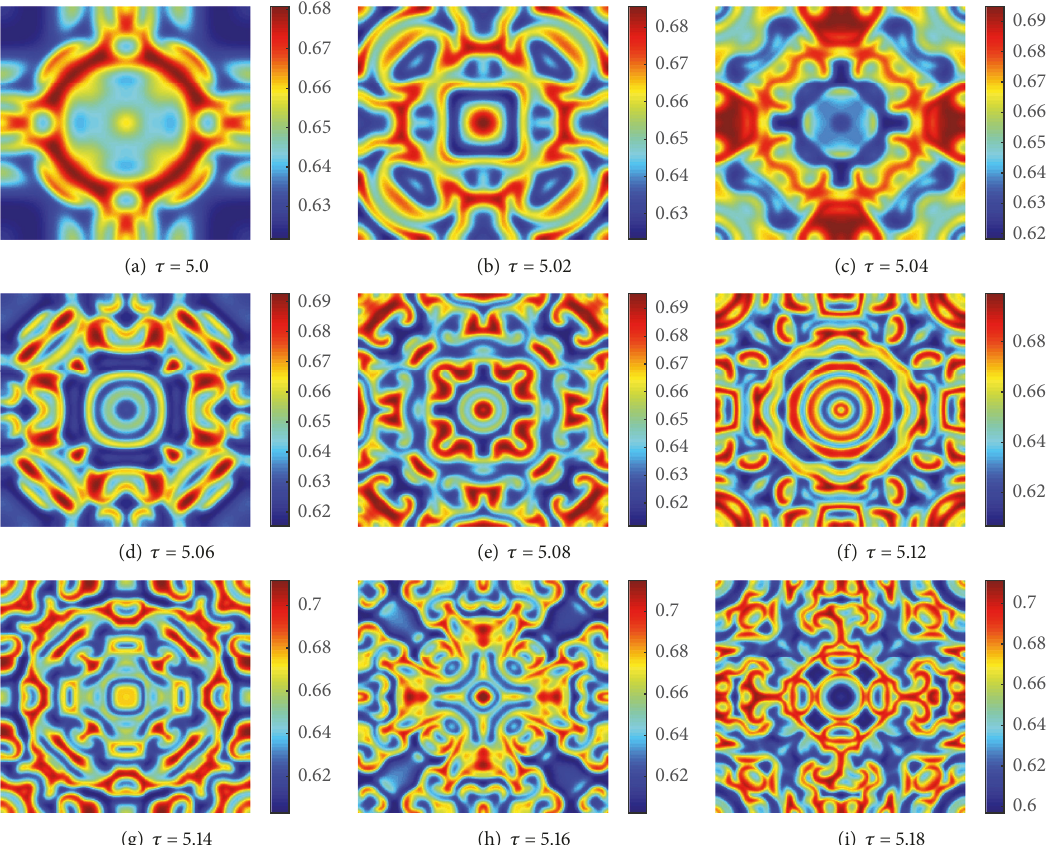
Figure 12: Various transient strongly symmetrical patterns when Neimark-Sacker-Turing instability occurs on the front part of route to chaos. 𝑎 = 1.63, 𝑏 = 0.1, 𝑐 = 0.32, 𝑑 = 0.22, 𝐷 𝐷 𝛿 = 10, 𝑛 = 200, and 𝑡 = 1 = 0.6, 2 = 1.2,